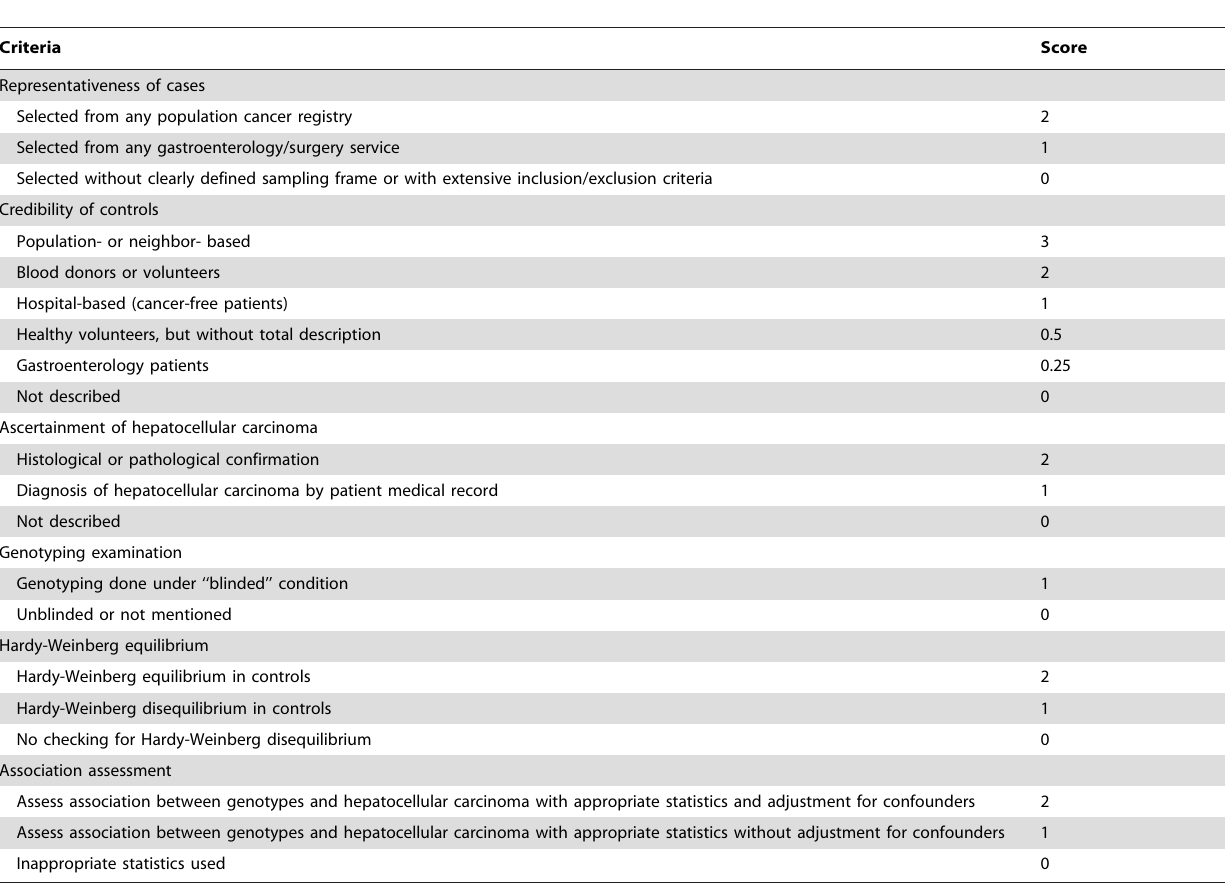
Table 1. Scale for quality